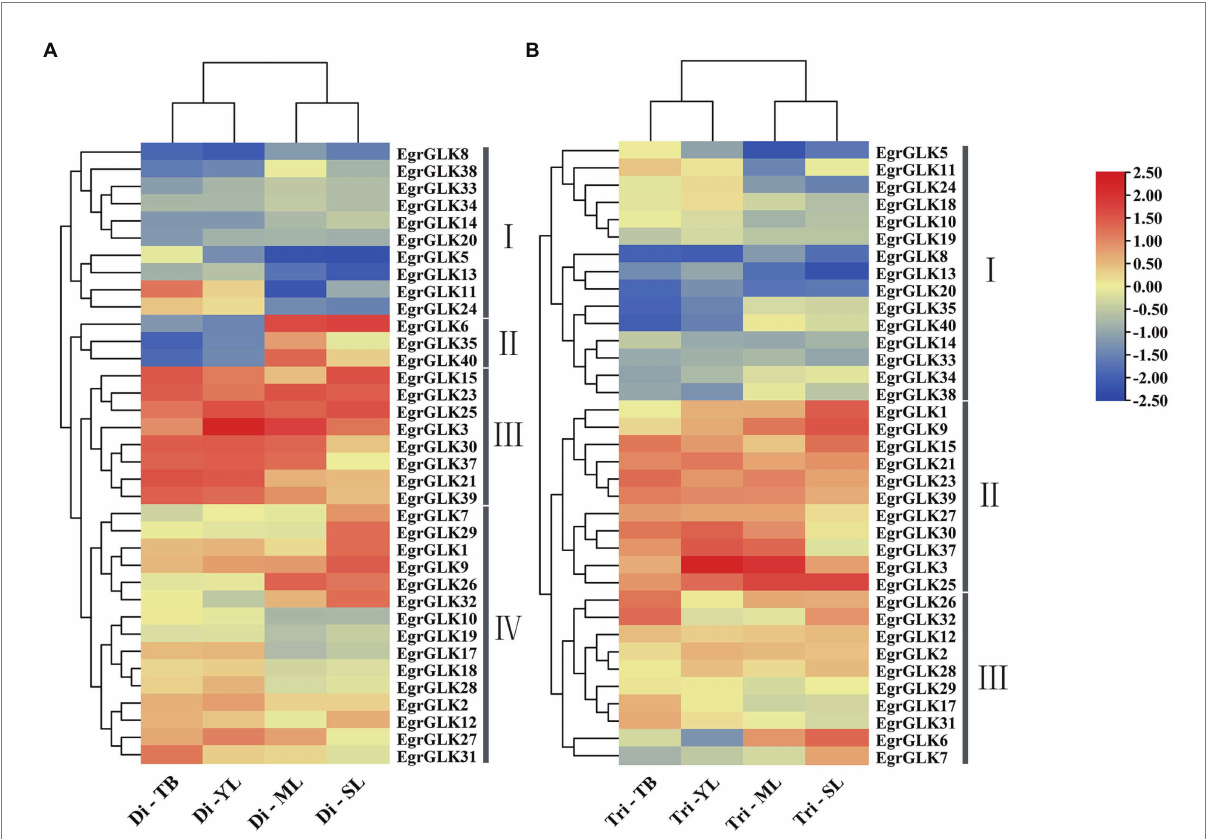
FIGURE 7 Expressions patterns of EgrGLK genes in leaves of E. urophylla . The expression patterns of EgrGLK genes in the terminal bud (TB), young leaves (YL), mature leaves (ML), and senescent leaves (SL) of diploid (A) and triploid (B)